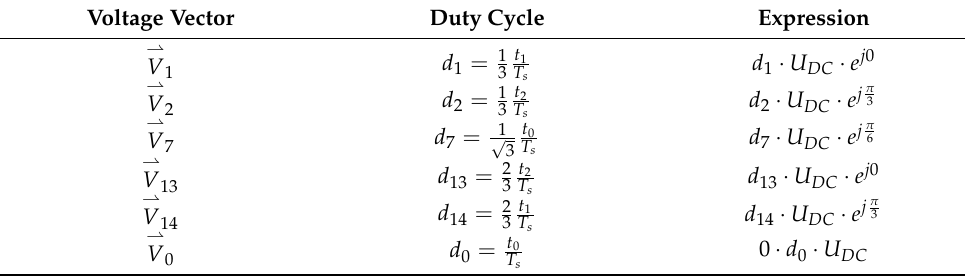
Table 3. Basic voltage vectors used inside Sector 1.